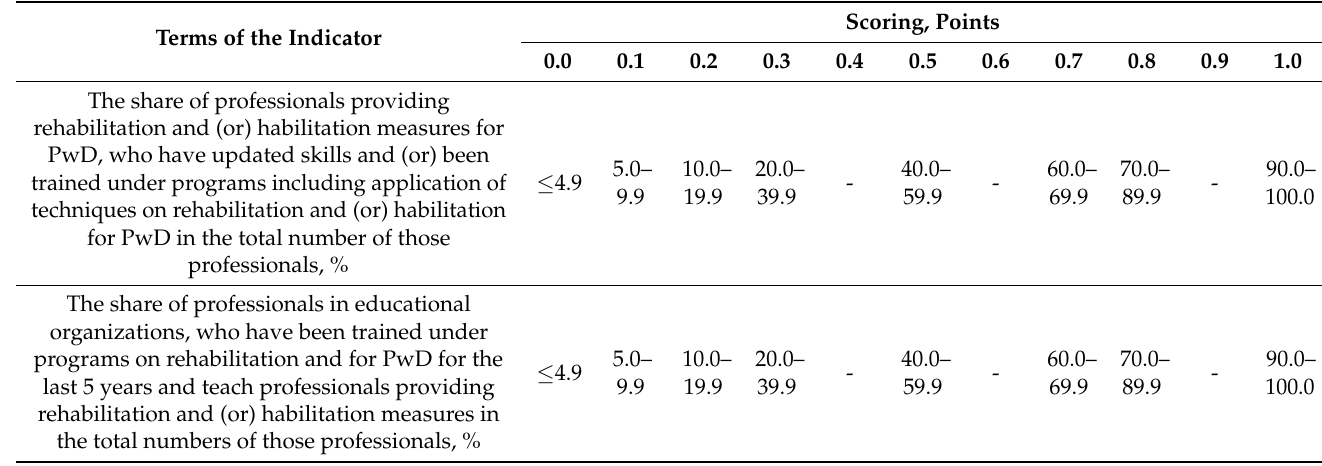
Table A3. Scoring of the indicator “The staffing of organisations providing rehabilitation and/or habilitation services with specialists”.